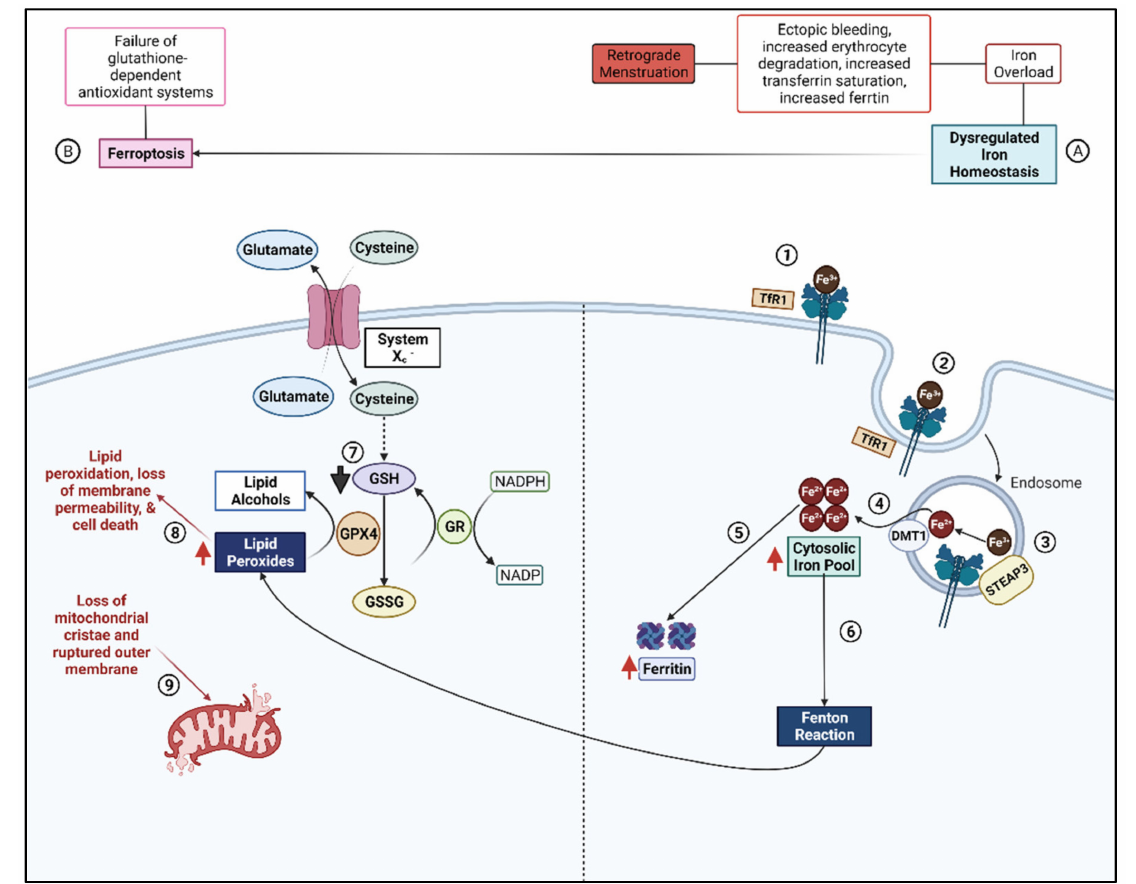
Figure 1. Dysregulated Iron Homeostasis Leads to Oxidative Stress and Ferroptosis in Endometrio- sis. (A) Retrograde menstruation, a proposed mechanism for disruption of iron homeostasis in endometriosis, induces ectopic bleeding in the peritoneal cavity (PC). This causes erythrocyte degra- dation which releases free iron. High levels of iron promote increased transferrin saturation. (1) Trans- ferrin binds to iron and delivers it to tissues where it binds to the transferrin receptor (TfR1). (2) The TfR1-Fe3+ complex enters the cell in an (3) endosome where acidification enables the separation of ferric iron (Fe3+) from the receptor. Six transmembrane epithelial antigens of the prostate 3 (STEAP3) catalyzes the conversion of ferric iron to ferrous iron (Fe2+). (4) Ferrous iron leaves the endosome and accumulates in the cytosolic iron pool. (5) Increased levels of iron in the cytosolic pool leads to increased levels of the intracellular iron storage protein, ferritin. (6) A portion of excess iron will undergo the Fenton reaction to generate free radicals which can damage lipids, proteins, and DNA. (B) This schematic represents a simplified diagram of ferroptosis, an-iron dependent mechanism of cell death. Ferroptosis occurs when glutathione-dependent antioxidant systems fail due to the accumulation of excessive reactive oxygen species (ROS). (7) There is decreased availability of reduced glutathione (GSH) due to excessive intracellular ROS. GSH is required for the conversion of lipid per- oxides to non-toxic lipid alcohols by the enzyme glutathione peroxidase (GPX4). (8) Lipid peroxides accumulate and reduce membrane permeability and (9) promote the loss of mitochondrial cristae which contributes to mitochondrial outer membrane rupture. The intracellular accumulation of lipid peroxides and decreased total antioxidant capacity (TAC) eventually leads to cell death. Adapted from “Role of Lipin-1 in Modified-LDL Induced Pro-inflammatory Response”, by Biorender.com (2022). Retrieved from https://app.biorender.com/biorender-templates (accessed on 18 July